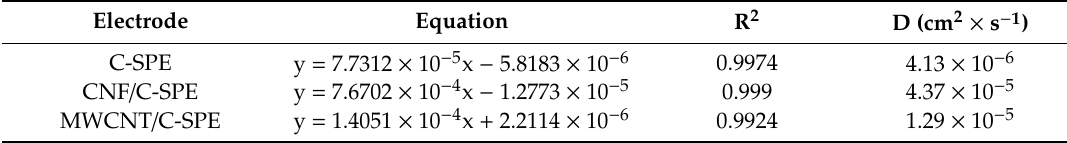
Table 5. The linear fitting equations (I pa vs. v 1 / 2 ), R 2 and D of ca ff eic